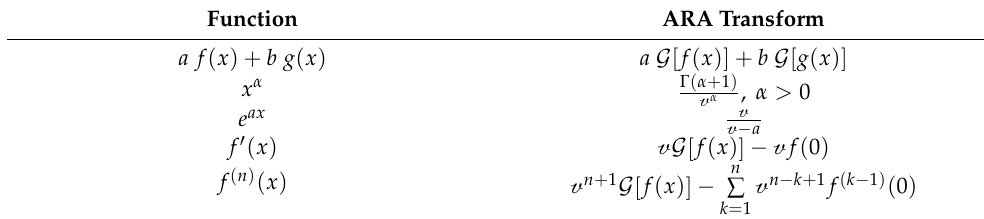
Table 1. Properties of ARA